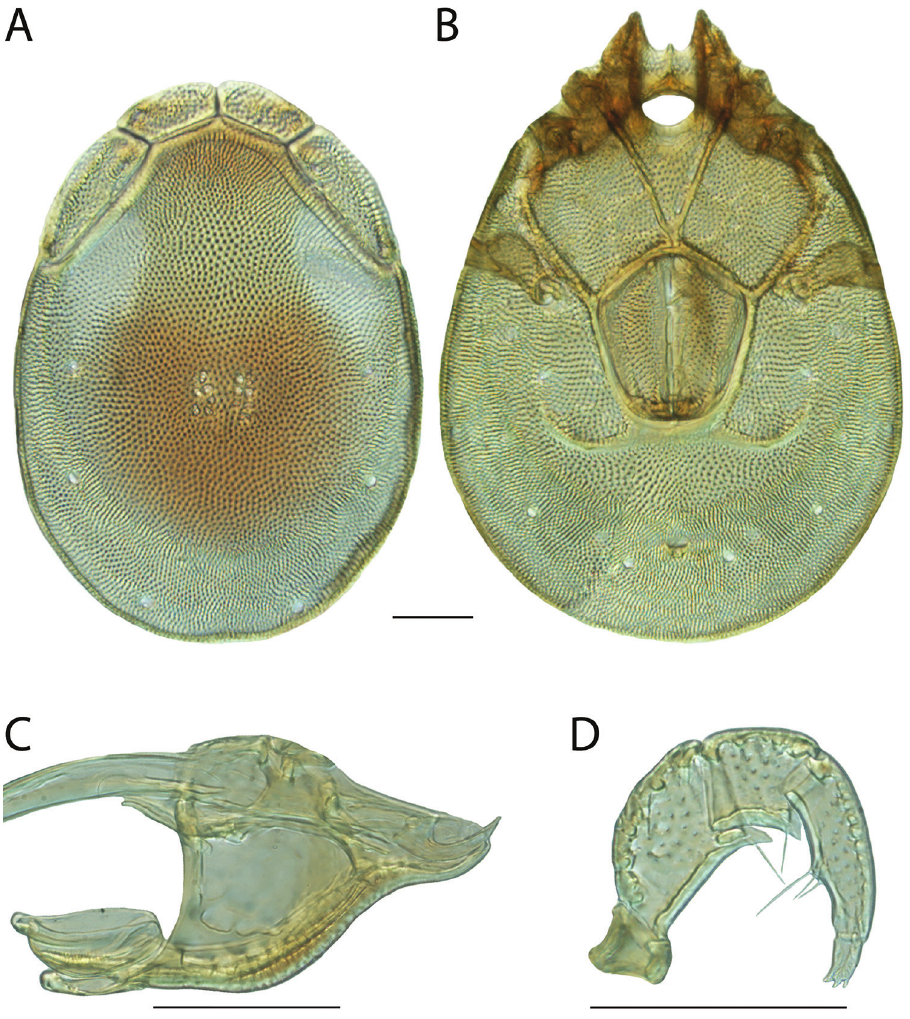
Figure 176. Torrenticola olliei sp. n. female: A dorsal plates B venter (legs removed) C subcapitulum D pedipalp (setae not accurately depicted). Scale = 100